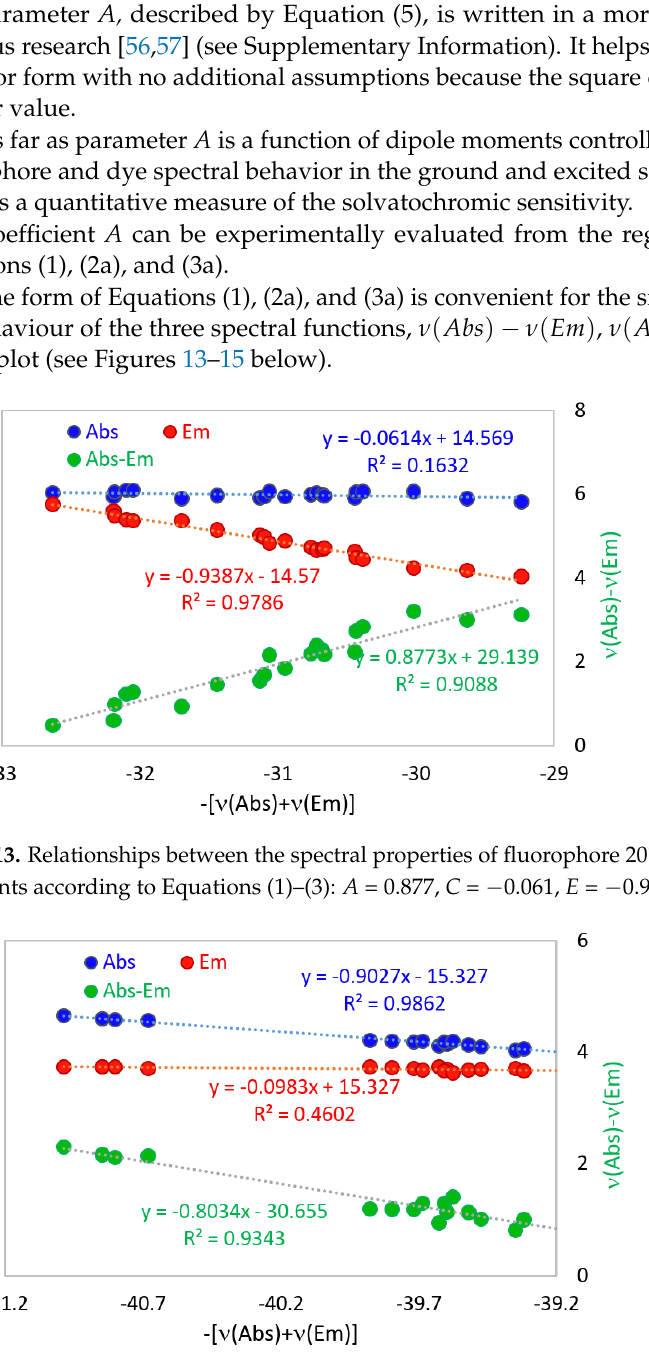
Figure 14. Relationships between the spectral properties of fluorophore 2018 Ripoll–4 in a series of solvents according to Equations (1)–(3): A = − 0.803, C = − 0.903, E = − 0.098.